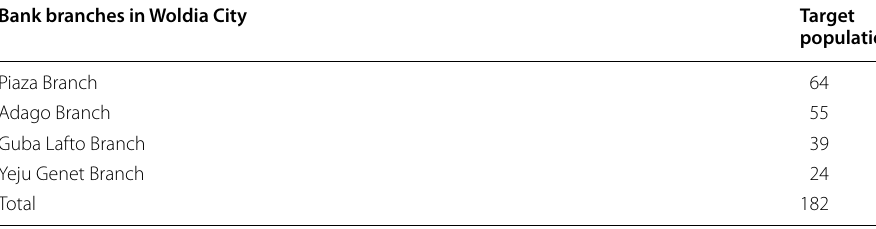
Table 1 Target population of the study. Source: respective branch manager (2020) Bank branches in Woldia